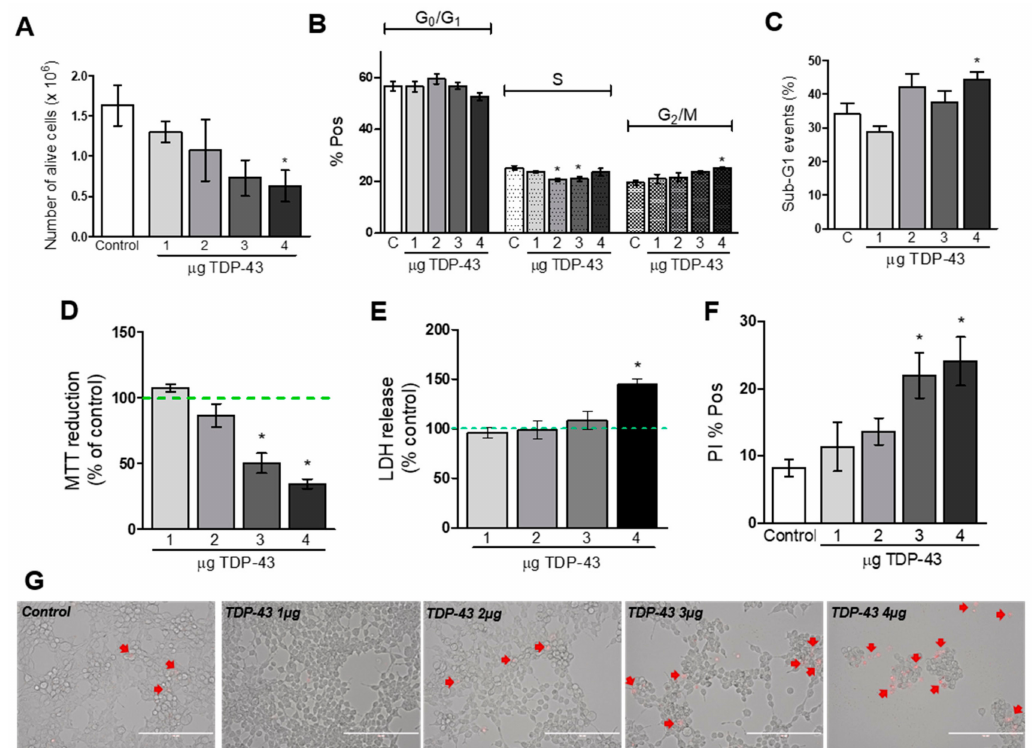
Figure 3. TDP-43 overexpression induces a decrease in cellular viability measured after 48 h of transfection. ( A ): Number of alive cells analyzed by trypan blue exclusion ( n = 3; * p < 0.05). ( B ) Cell cycle analysis performed by flow cytometry ( n = 4–5; * p < 0.05). ( C ) Percentage of sub-G1 events (fragmented nuclei) analyzed by flow cytometry ( n = 4–5; * p < 0.05). ( D ) Cell viability analyzed by MTT reduction ( n = 4; * p < 0.05). ( E ) LDH released in the medium ( n = 4; * p < 0.05). ( F ) Percentage of positive cells for PI fluorescence ( n = 5–6; * p < 0.05). ( G ) Microscopic analysis of cells transfected with increasing concentrations of TDP-43 and incubated with PI (scale bar = 200 µ